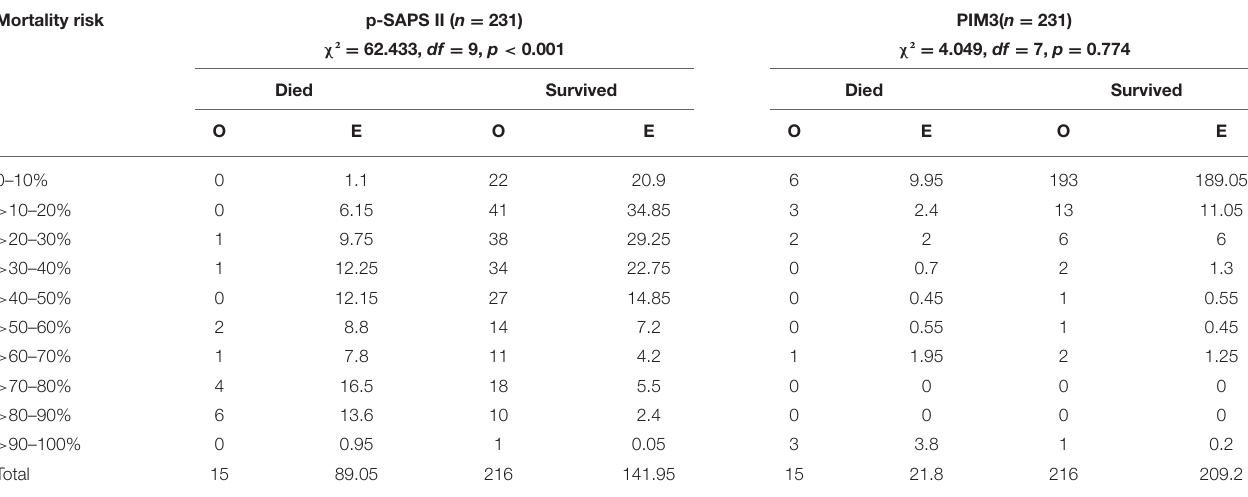
TABLE 3 | Goodness of fit test for p-SAPS II and PIM3 respectively. Mortality risk p-SAPS II ( n =